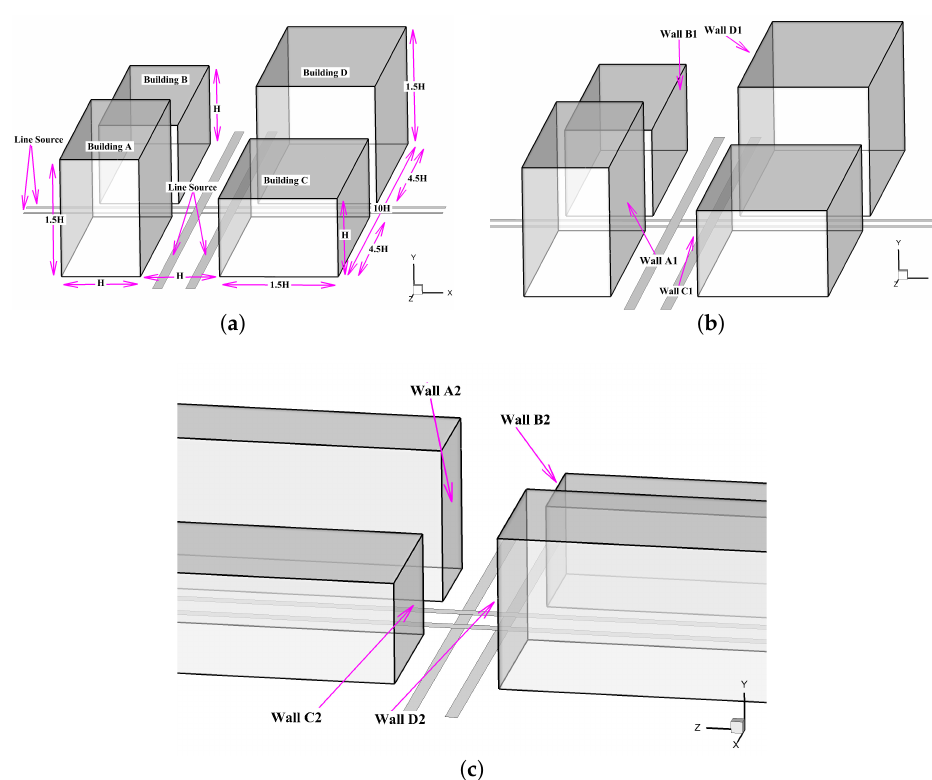
Figure 2. A model street canyon intersection: ( a ) building distribution, ( b ) walls 1, and ( c ) walls